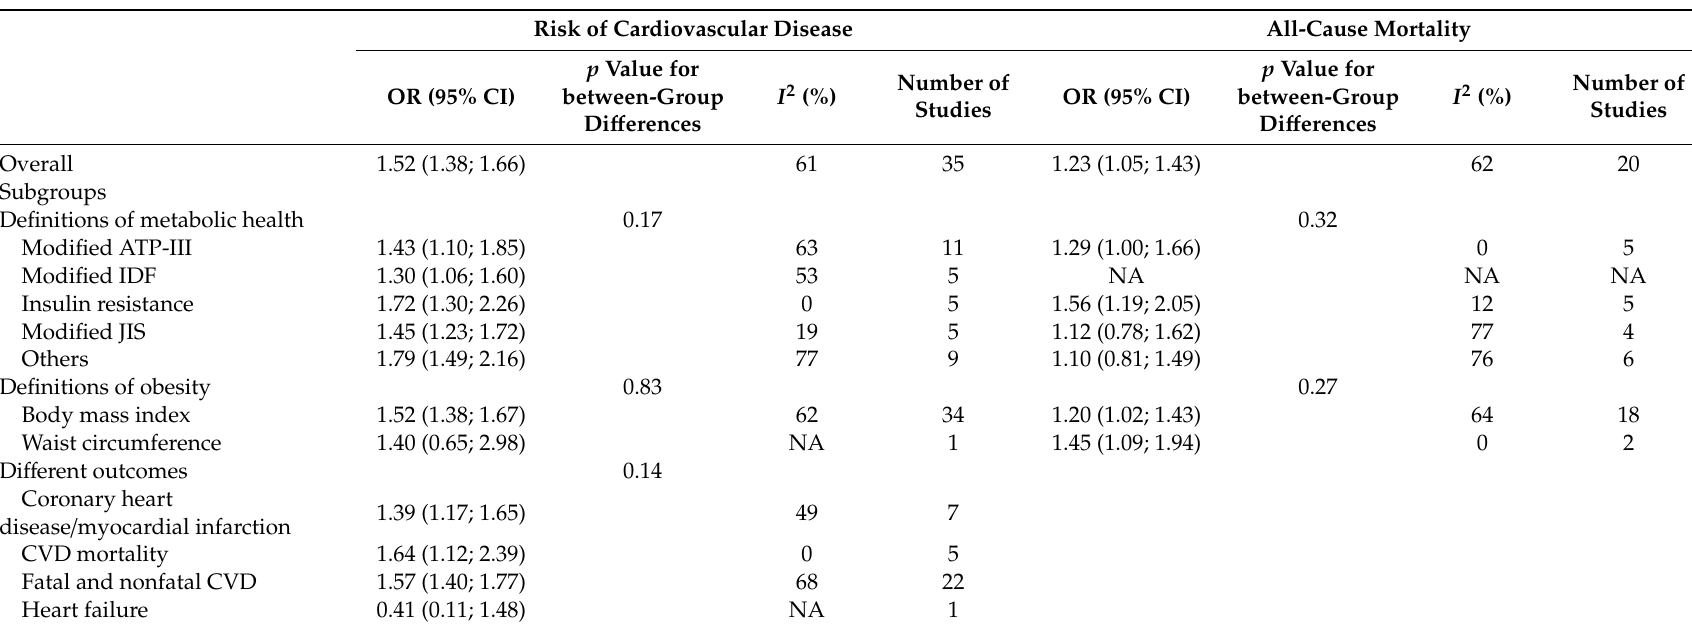
Table 1. Risk of Cardiovascular Disease and All-cause Mortality Associated with Metabolically Healthy Obesity in Di ff erent Subgroup Analyses.